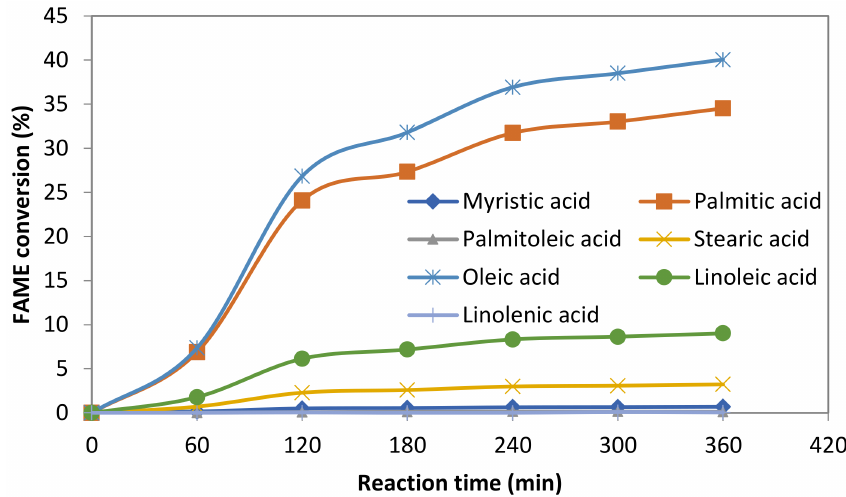
Figure 5. Evaluation of FAME conversions with time (catalyst loading 4 wt.%, methanol to oil molar